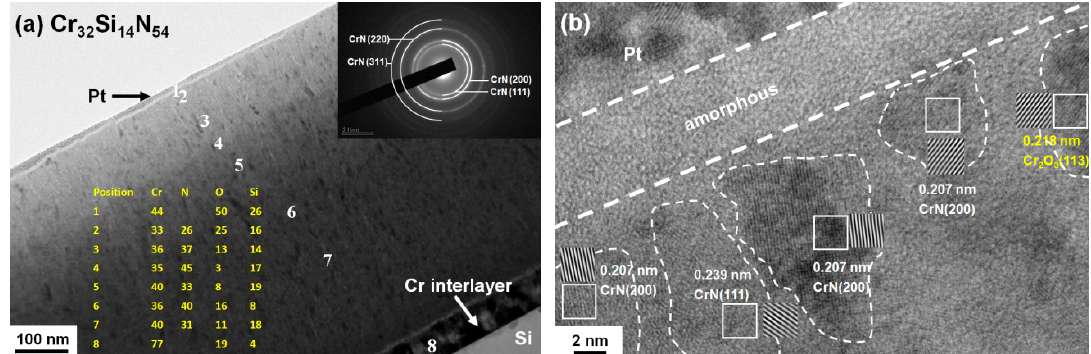
Figure 10. ( a ) Cross-sectional TEM image, selected-area diffraction pattern (inset), and EDS results (given in yellow) of the Cr 32 Si 14 N 54 coating after annealing in 15 ppm O 2 –N 2 at 600 °C for 16 h; ( b ) the high-resolution TEM image.